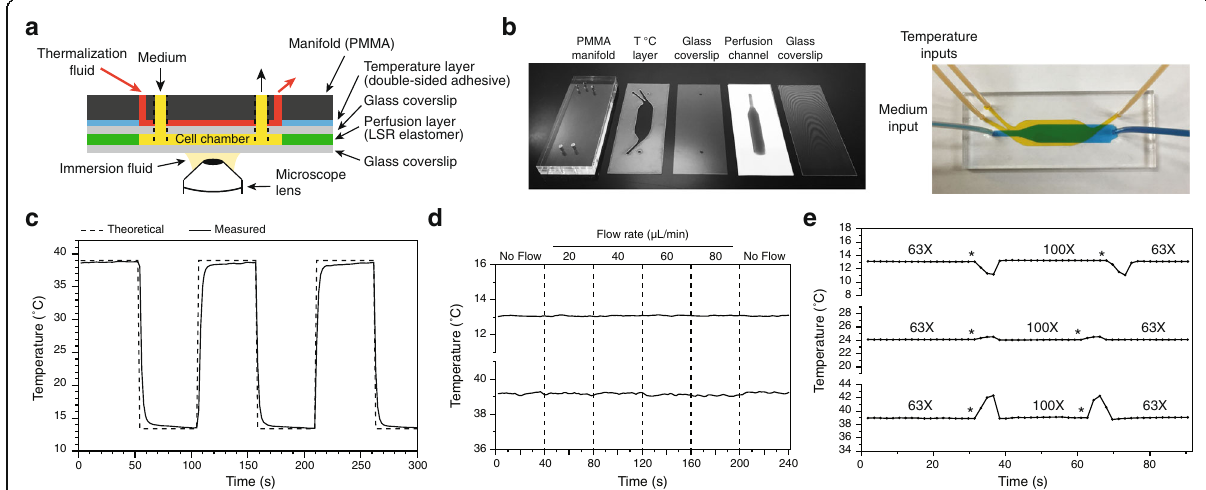
Fig. 2 Microfluidic-based temperature control of the elastomer microfluidic chip. a . Schematic of an elastomer chip integrating a temperature control. b. Left: Layers used to mount the chip in a . For the perfusion layer, a white background and a blue dye were used for ease of visualization. Right: assembled chip. An orange dye (temperature control) and a blue dye (perfusion layer) were used for ease of visualization. Connecting tubings were attached to the manifold using epoxy glue. See Additional file 4C for channel dimensions. The temperature control is referred to as T °C layer. c-e. All experiments used chips as in Additional file 4B, and all temperature measurements within the cell channels were made using metal electrodes deposited on glass coverslips [13]. c . Fast temperature shifts using the temperature control system. A series of switches were triggered (without a constant flow of medium) and the theoretical sample temperature was compared to experimental measurements. The theoretical temperature was calculated based on the calibration equation (Additional file 2) as well as the measured lens and thermalization fluid temperatures. d. The temperature of the sample is robust to changes in the medium flow rate. Sample temperature was set below (top) or above (bottom) ambient, and the medium flow rate was altered. No temperature changes were measured, even at the highest flow rate (80 μ L/min). e. The temperature of the sample is robust to changes in immersion lens. Sample temperature was set below (top), comparable to (middle) or above (bottom) ambient, and the lens was switched back and forth between a 63X and a 100X objective (asterisks: timings of the switches). No medium flow was applied, as it has no impact on the temperature (see d ). Only transitory changes in temperature were observed, corresponding to the short periods during which the microsystem was not in contact with the